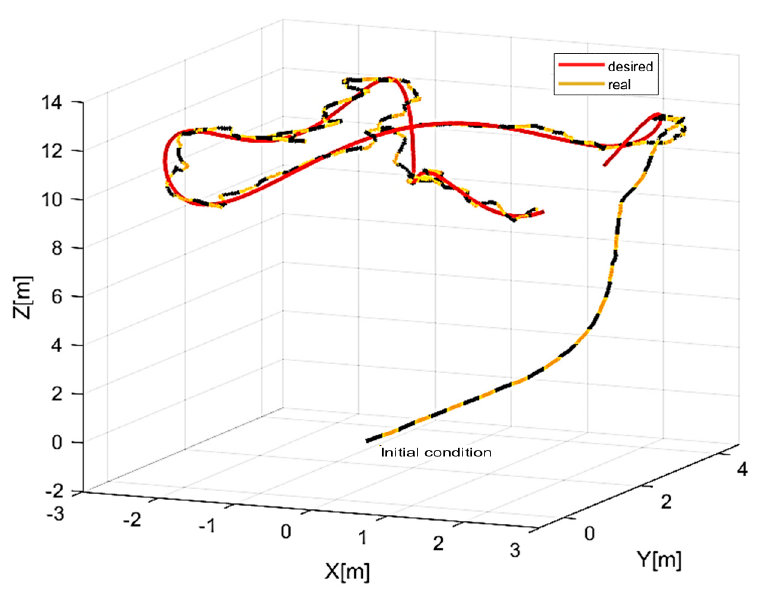
Figure 12. Trajectory tracking: SMC controller.